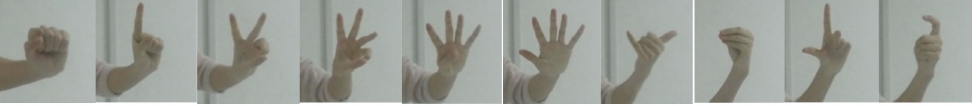
Figure 5. The predefined hand gestures for numbers from zero to nine.